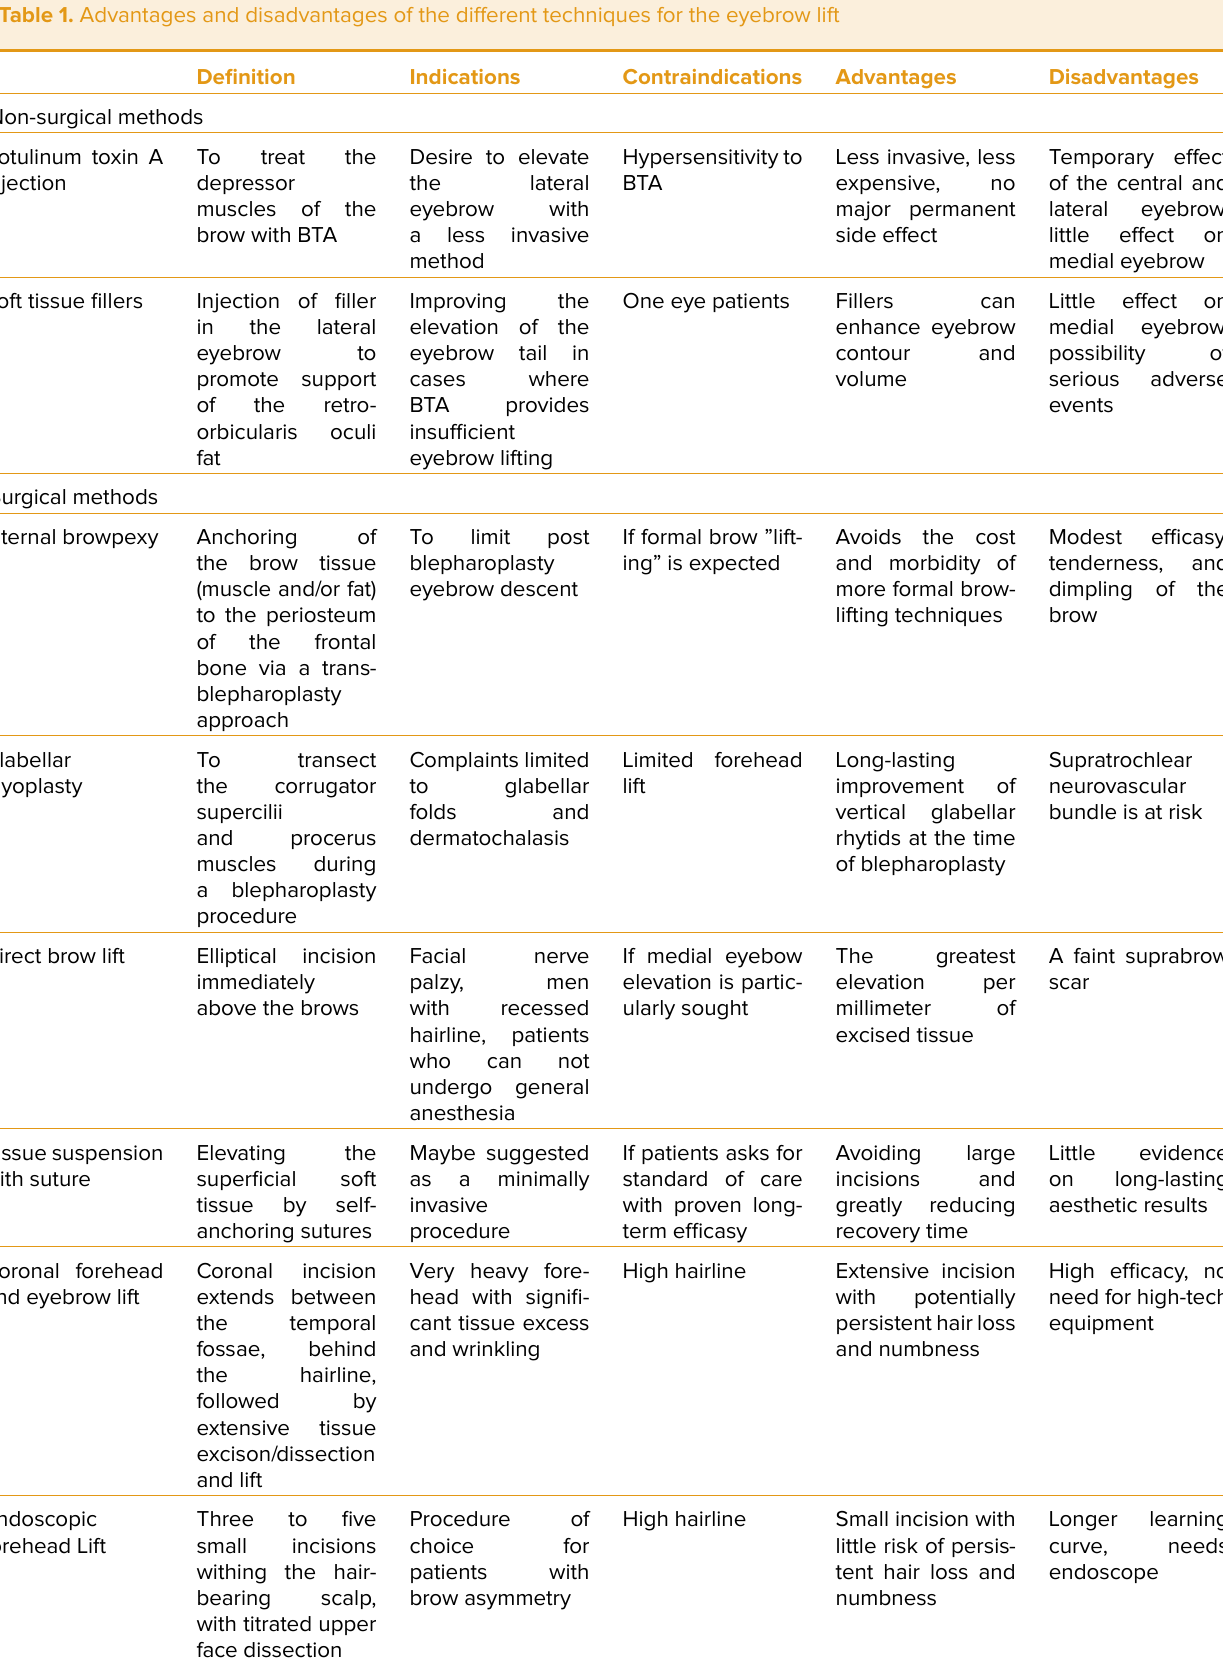
Table 1. Advantages and disadvantages of the different techniques for the eyebrow